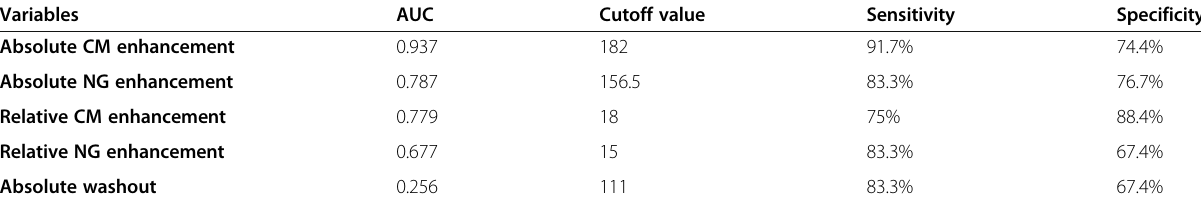
Table 2 AUC, optimal cutoff values, and corresponding performances of dynamic parameters for differentiation between clear cell RCC and non-clear cell RCC lesions